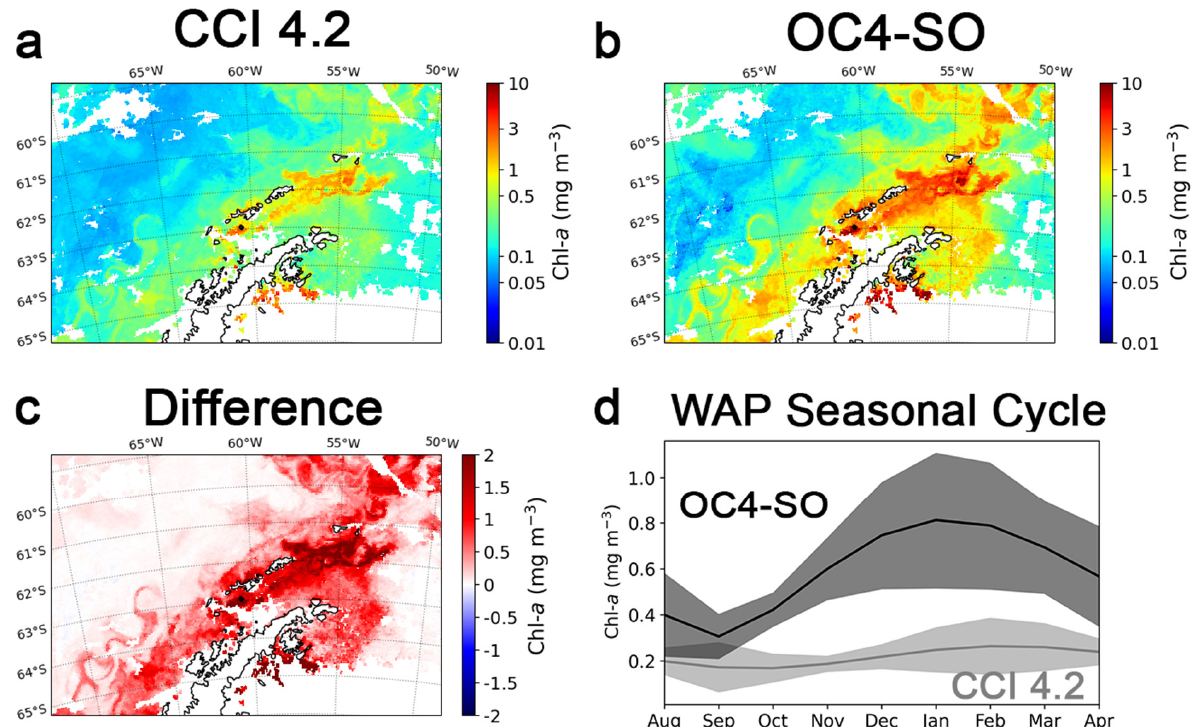
Figure 10. Satellite-derived Chl- a concentration for the Antarctic Peninsula on 2 March 2011, from CCI 4.2 ( a ) and using the OC4-SO algorithm ( b ), as well as their differences in terms of Chl- a concentrations ( c ). Comparison of the smoothed mean (lines) and standard deviation (shaded area) of the seasonal cycle between 1998 and 2019 (August to April), calculated using the weekly spatial average for the Western Antarctic Peninsula (WAP) between the Anvers and Elephant Island ( d ).